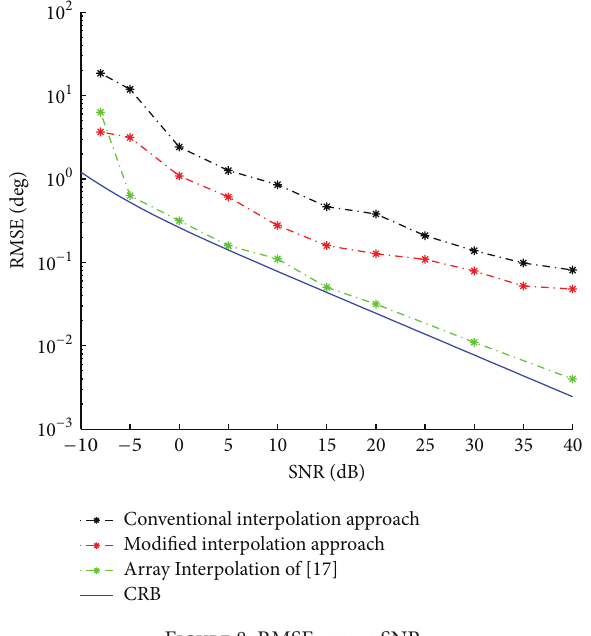
Figure 8: RMSE versus